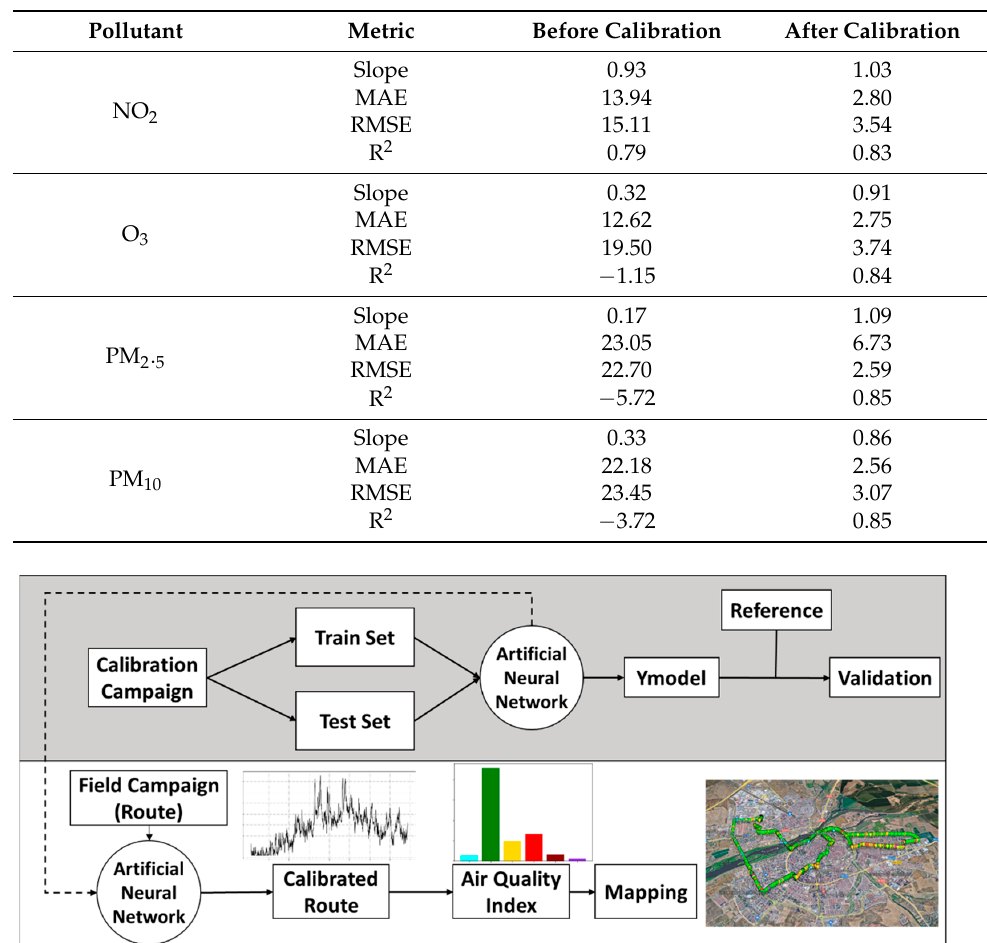
Table 1. Metrics of artificial neural network performance as a calibration algorithm. Measurement unit is micrograms per cubic meter ( µ g/m 3 ).